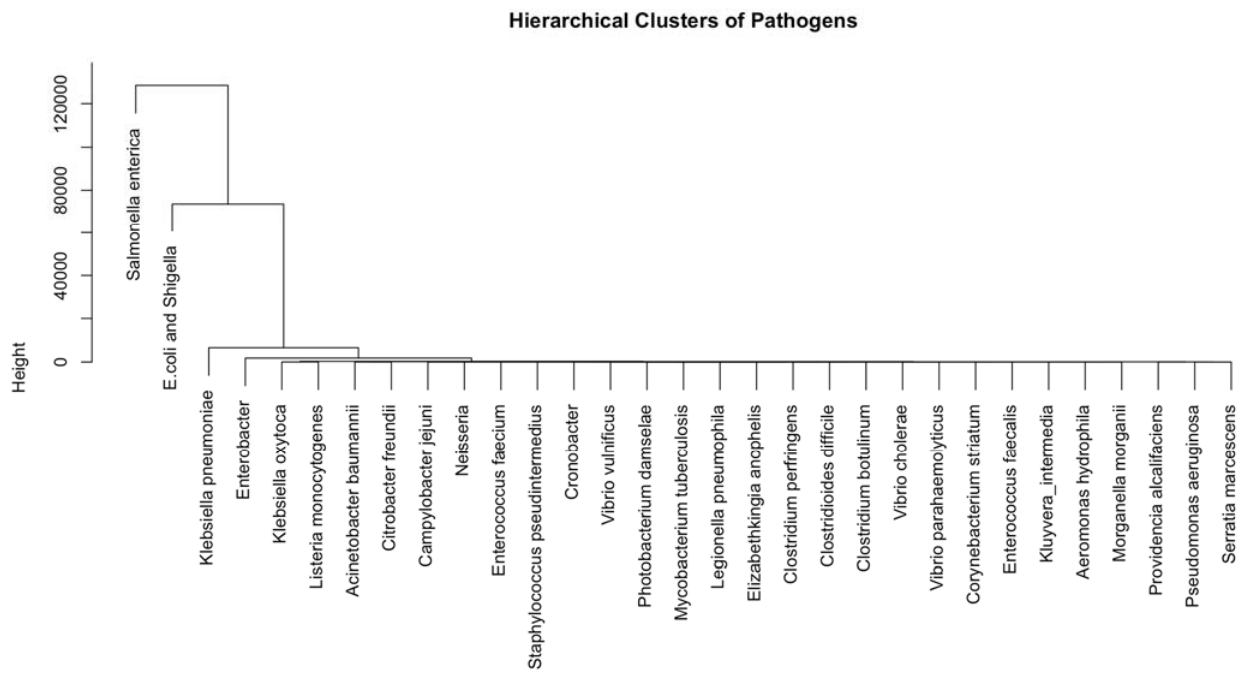
Figure 3. The hierarchical clustering result for pathogens carrying stress response genes in the US. Table 2. Major pathogens carrying stress response genes across all five countries (marked by the shading). South Africa